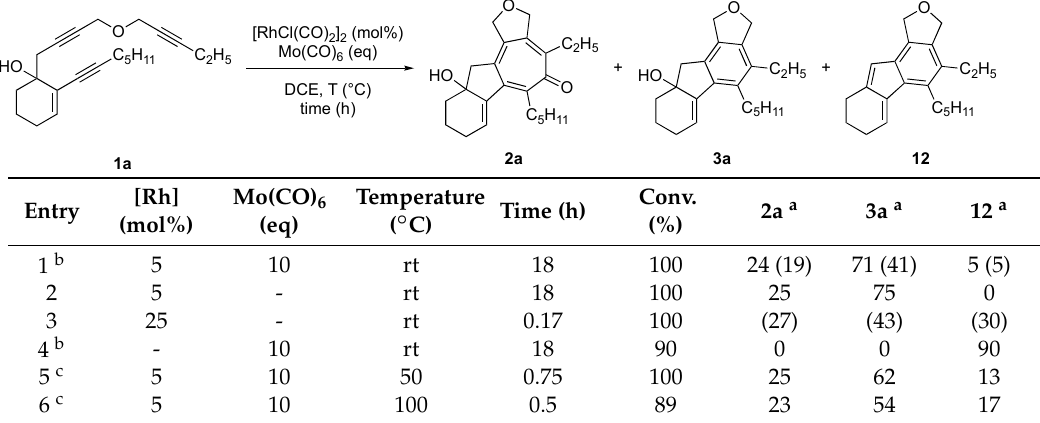
Table 1. Use of Mo(CO) 6 as CO source for the [2+2+2+1] carbonylative cycloaddition and competing pathways of triyne 1a .